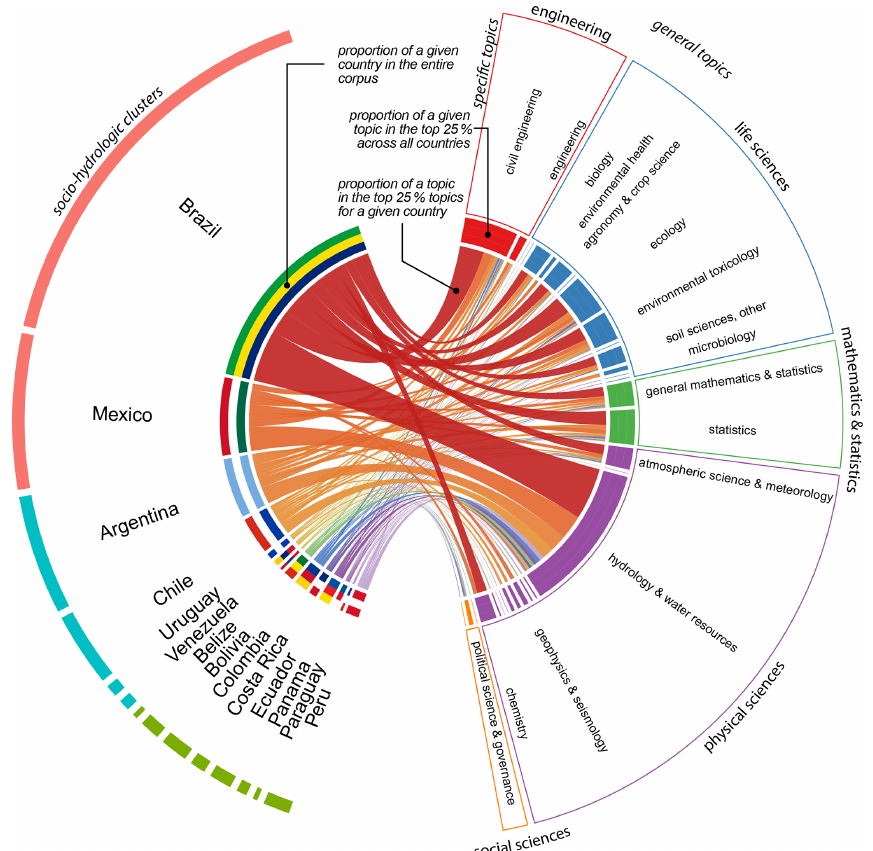
Figure 6. Composition of water research in LAC according to study location and top 25% of studied research topics. On the left, countries are identified individually and by their associated socio-hydrologic cluster. On the right, research topics are grouped by their general category. The top 50% of specific topics are listed within each general